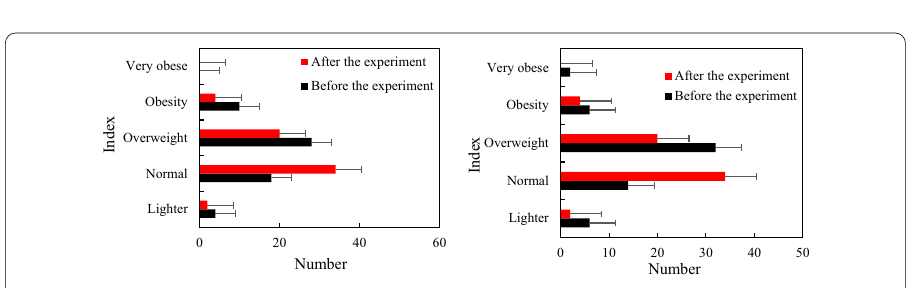
Fig. 11 BMI index statistics of students before and after the